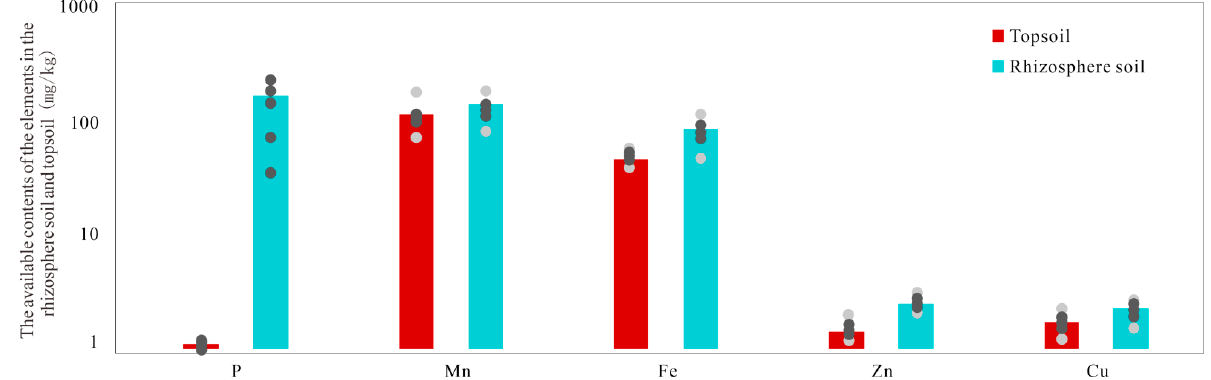
Figure 6. The available contents of the elements in the rhizosphere soil and